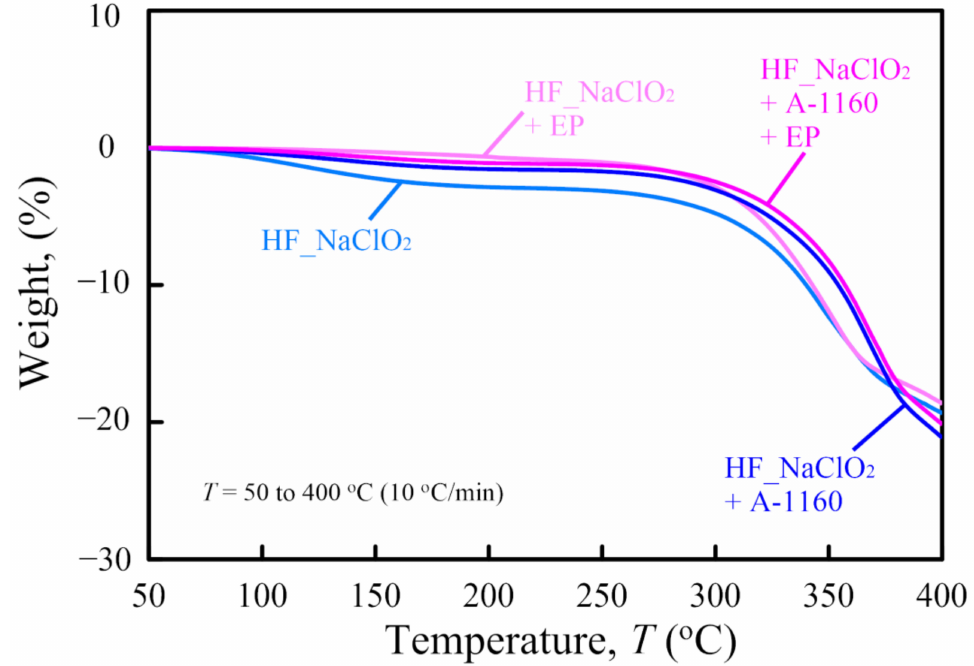
Figure 4. Weight as a function of temperature T (thermogravimetric (TG) curve) of various Scheme 1010. biomass composites. Table 1. Temperatures at 10 and 15 wt % loss of various surface-treated HF/PA1010 biomass composites. Temperature ( ◦ C) HF_NaClO 2 HF_NaClO 2 + EP HF_NaClO 2 + A-1160 HF_NaClO 2 + A-1160 + EP 10 wt % loss 340.1 342.9 354.1 357.2 15 wt % loss 362.2 362.3 370.4